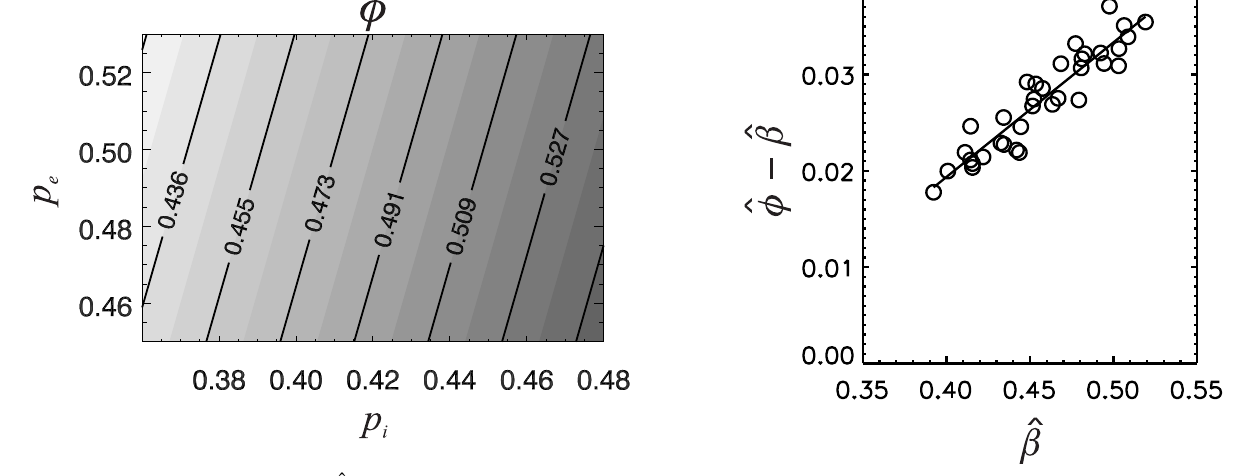
Fig. 11. Fitted plane to estimated ˆ φ .